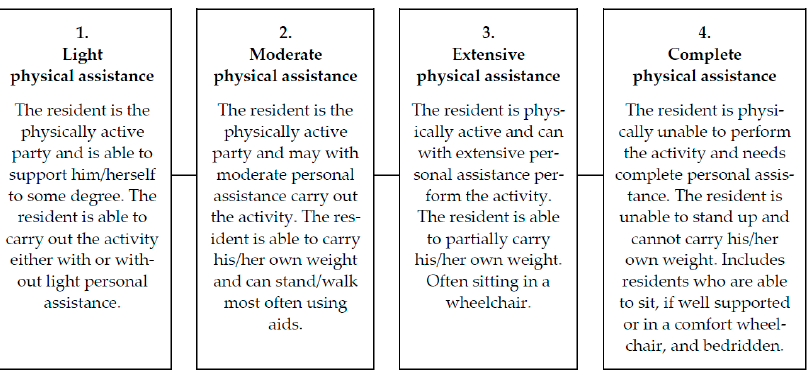
Figure 1. The resident need-for-physical-assistance scale.